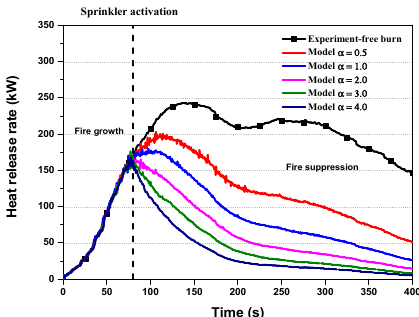
Figure 7. Variation of heat release rate for different extinguishing coefficients.